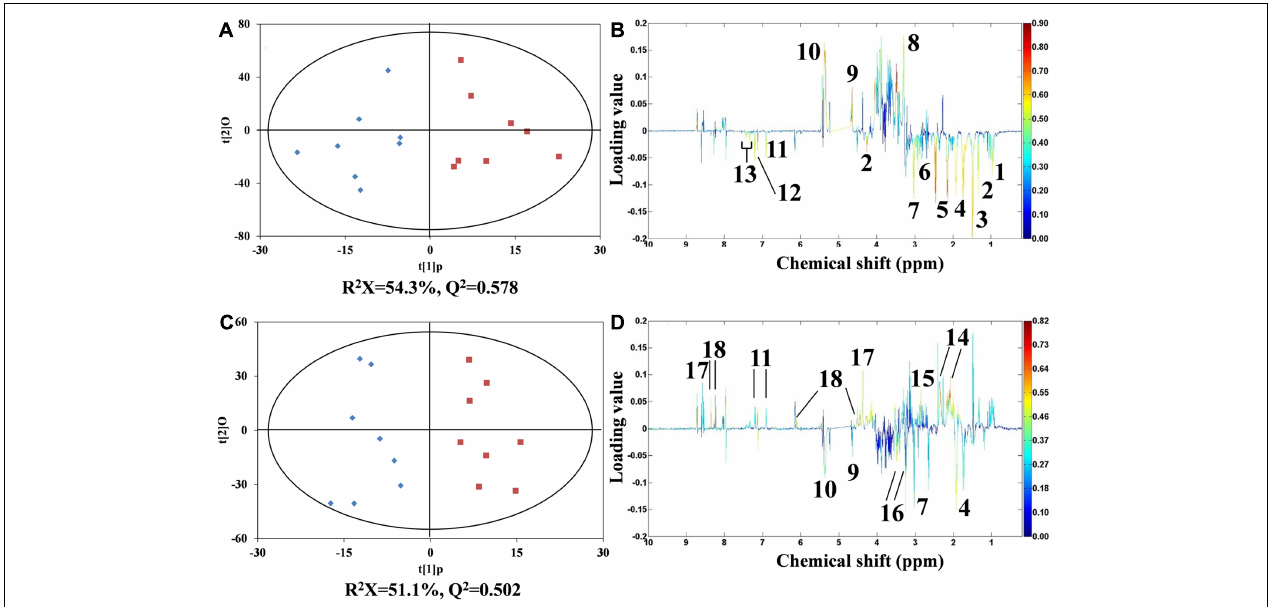
FIGURE 5 | O-PLS-DA scores plots from the analysis of 1 H NMR spectra using Mytilus galloprovincialis samples from the control ( (cid:169) ) and 12- and 324- µ g/L DEHP-treated groups. Presenting hormesis ( (cid:110) ), control versus the 12- µ g/L DEHP group (A) , and control vs. the 324- µ g/L DEHP group (B) , with corresponding coefficient plots (C,D) . The metabolite variations between the two classes (DEHP treatment vs. control) are indicated by the color map. Peaks in the positive direction indicate that metabolites are higher in the DEHP-treated groups. Accordingly, the negative peaks are labeled for the more marked metabolites in the control group. (1) isoleucine, (2) threonine, (3) alanine, (4) arginine, (5) glutamine, (6) asparagine, (7) lysine, (8) unknown 1 (3.30 ppm), (9) glucose, (10) glycogen, (11) tyrosine, (12) histidine, (13) phenylalanine, (14) glutamate, (15) aspartate, (16) taurine, (17) homarine, and (18)